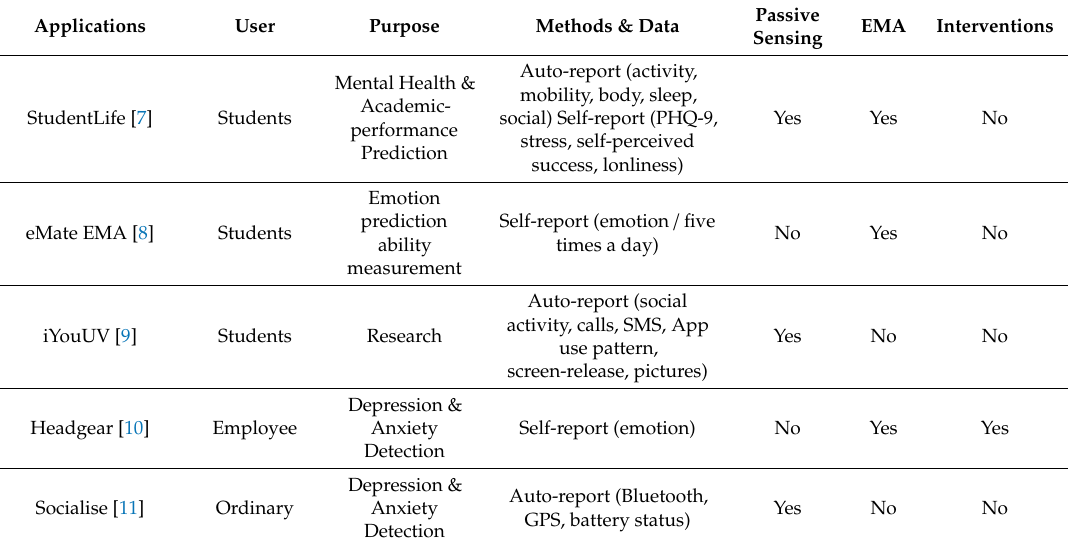
Table 1. Literature review: depression tracking with passive